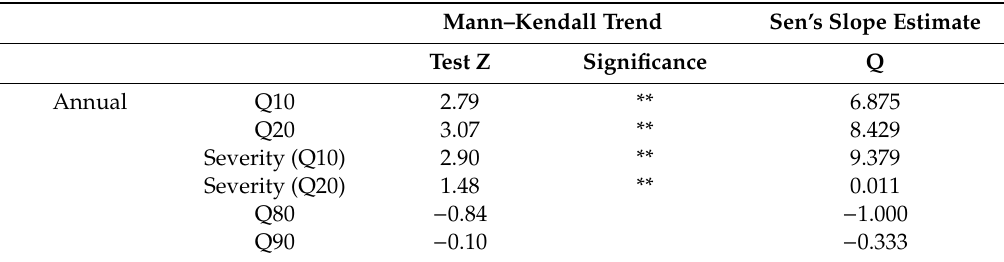
Table 3. Statistics (Z of the Mann–Kendall Test and Q of the Sen’s Slope Estimator) for low and high flow trend